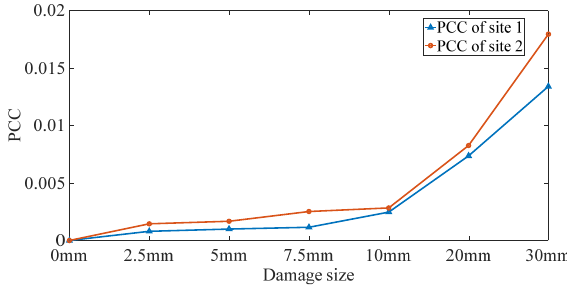
Figure 17. Damage index based on PCC of site 1 and site 2.